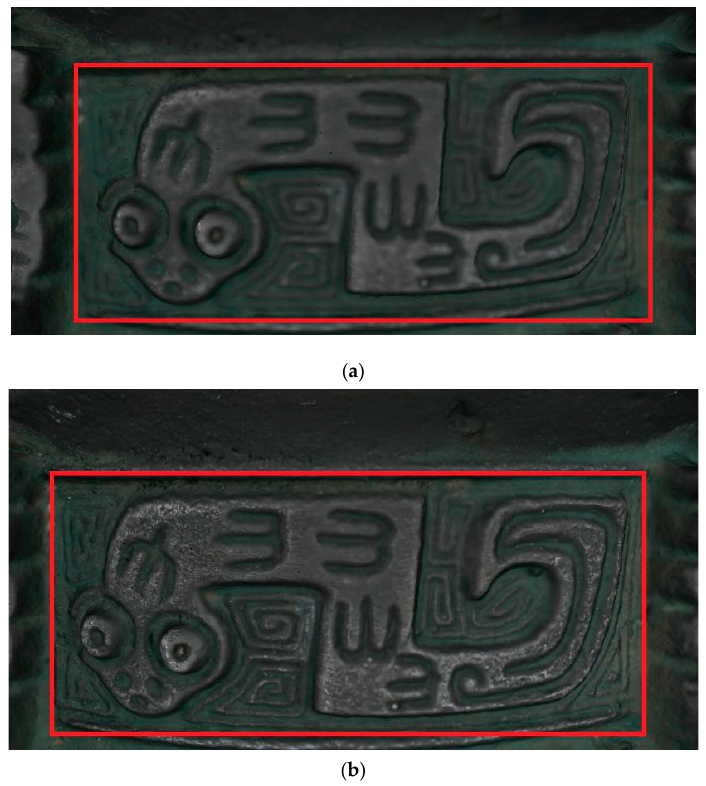
Figure 8. Three-dimensional model before and after texture selection with definition quality. ( a ) Texture definition index evaluation before selection; ( b ) texture definition index evaluation after